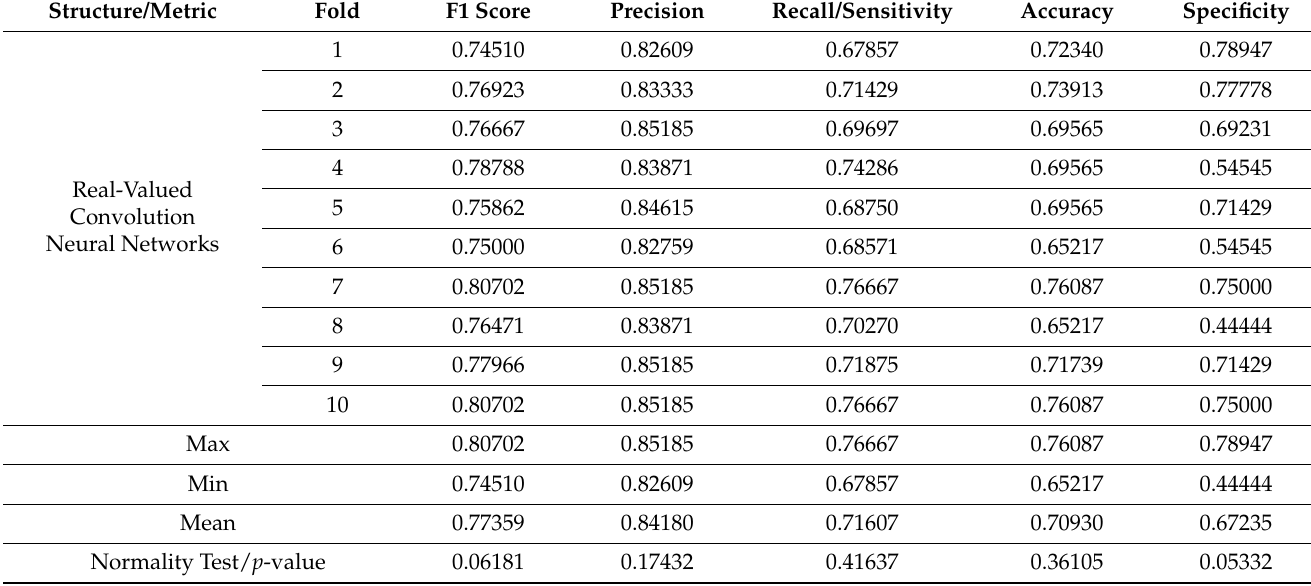
Table 13. Results obtained with the real-valued convolution network studied for the Pascal dataset. Structure/Metric